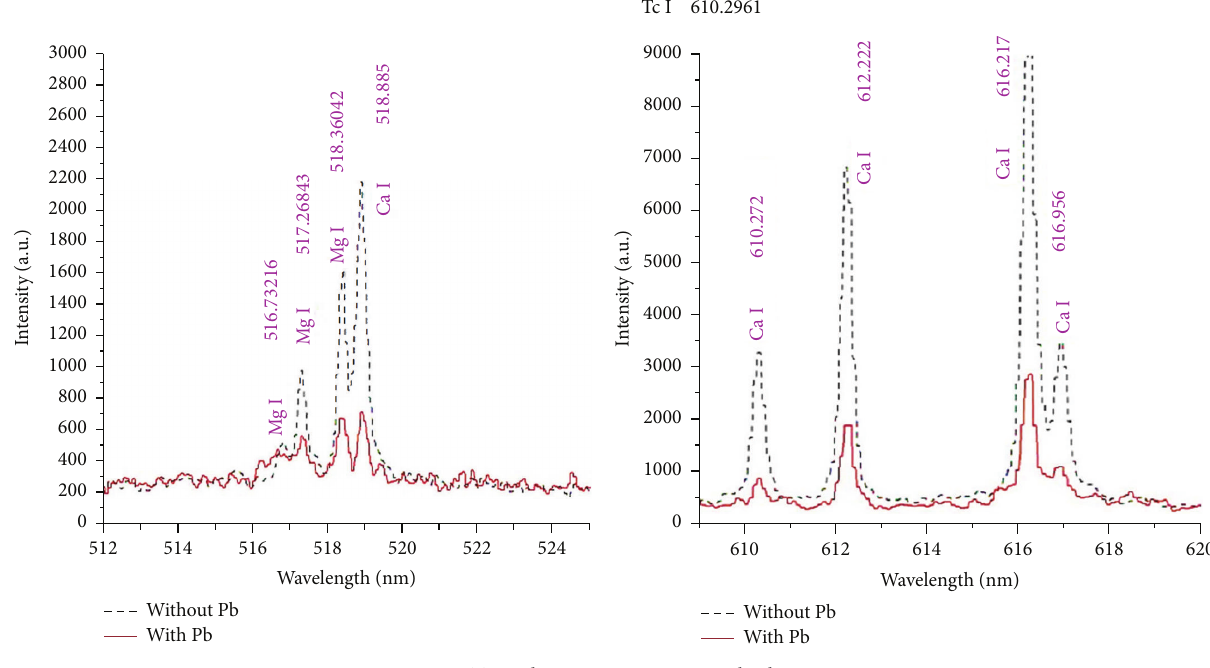
Figure 3: Typical mean LIBS spectra in both groups.